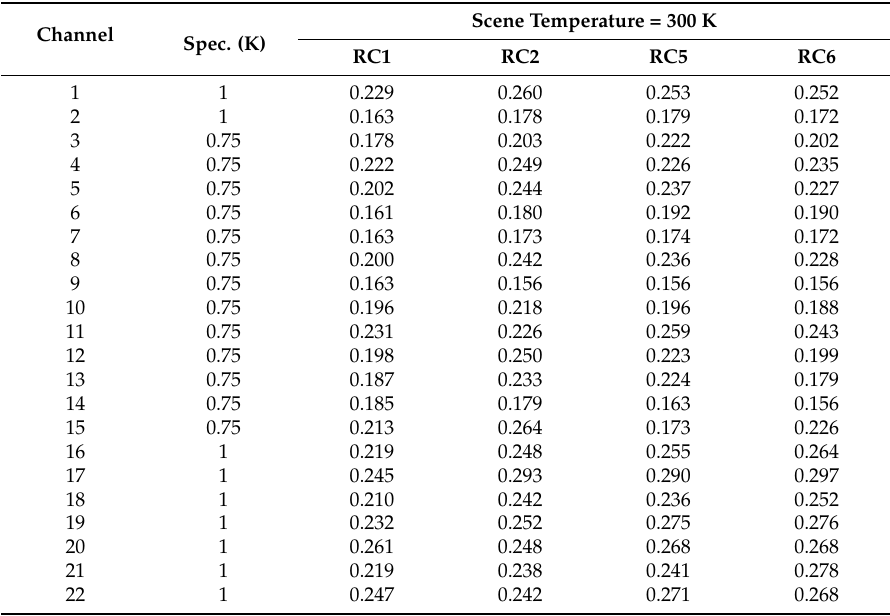
Table 5. SNPP ATMS PFM calibration accuracy at warm scene for four redundant configurations (RC1, RC2, RC5, RC6).